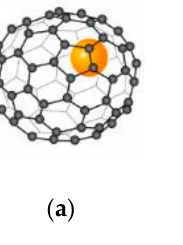
Figure 1. Structure of ( a ) endometallofullerene Fe@C 60 and ( b ) P84 copolyimide.